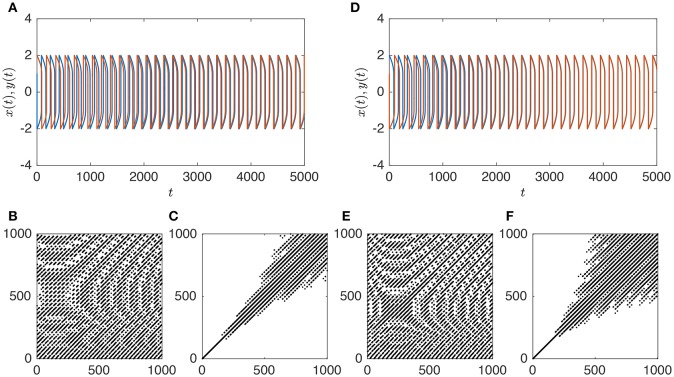
Temporal dynamics (A) of a system of two (in red and blue) coupled van der Pol oscillators with ϵ1 = 0.01. CRP (B) and MdRP (C) for the time series shown in (A) with D = 2, τ = 1, and T = 0.01 for both CRP and MdRP. (D–F) show the same, but for ϵ1 = 0.02. In both cases ϵ2 = 5ϵ1.